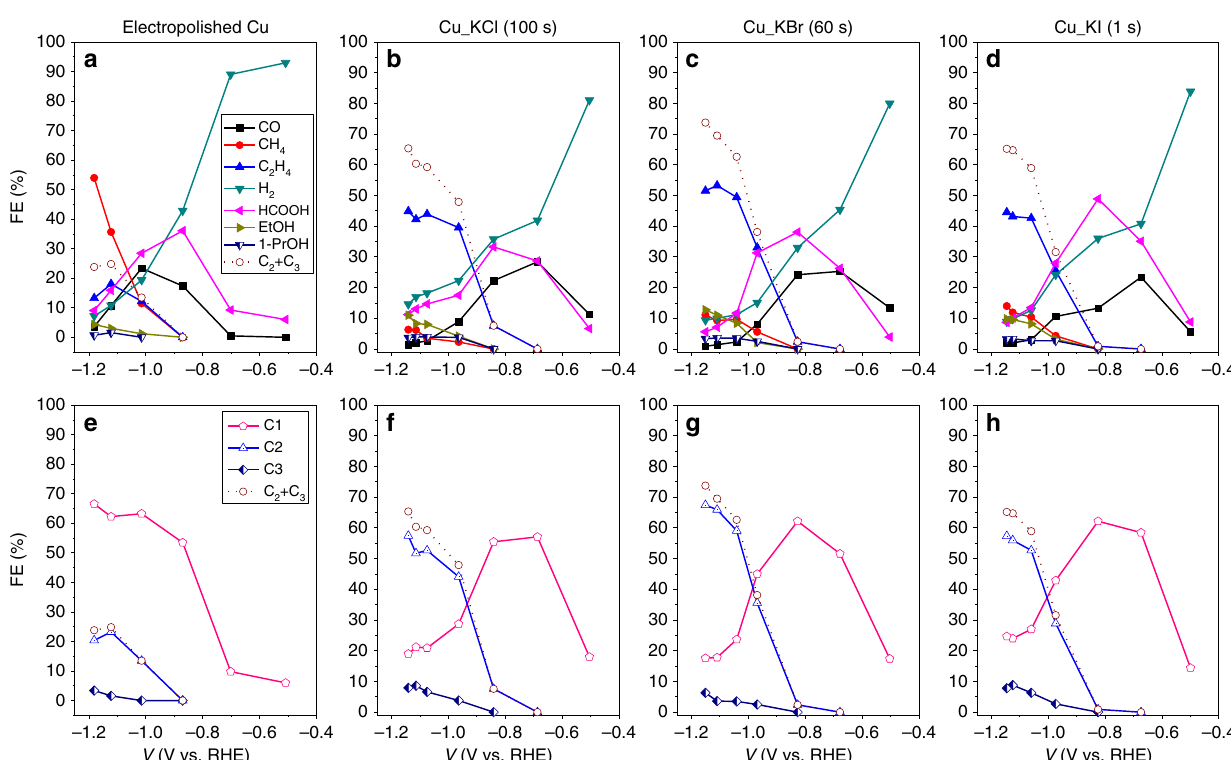
Fig. 5 Performance of catalysts for electrochemical CO 2 reduction reaction. Potential-dependent faradaic ef fi ciency of the products from the CO 2 RR products on electropolished Cu ( a ), chlorinated Cu ( b ), brominated Cu ( c ), and iodinated Cu ( d ). Anodic halogenation of Cu was performed in 0.1 M KCl at 1.1 V vs. Ag/AgCl for 100 s ( b ); in 0.1 M KBr at 0.18 V vs. Ag/AgCl for 60 s ( c ); in 0.1 M KI at − 0.2 V vs. Ag/AgCl for 1 s ( d ). e – h FEs of C 1 , C 2 , and C 3 products from the same results shown in the corresponding upper plot. C 1 products include CO, formate, and CH 4 . C 2 products include C 2 H 4 , ethanol, acetate, acetaldehyde, and glycolaldehyde. C 3 products include n-propanol, propionaldehyde, and allyl alcohol. Data were acquired during 40 min of electrochemical CO 2 RR at a constant potential in 0.1 M KHCO 3 saturated with CO 2 . FE is shown as a function of the iR-corrected potential in RHE scale. Data legends apply to all plots in the same row. Source data are provided as a Source data fi